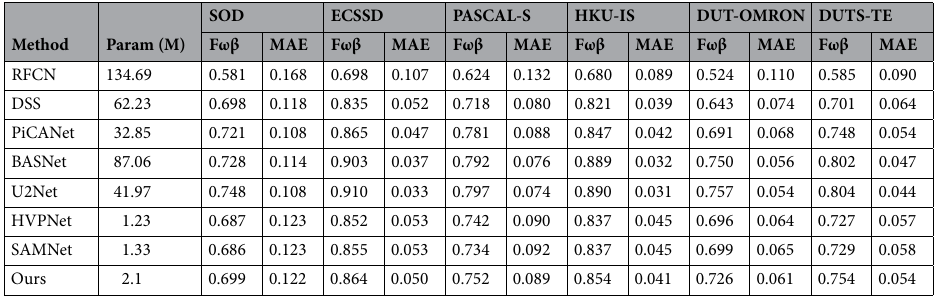
Table 1. Comparison with five traditional methods and two lightweight methods on F ω β ↑ and MAE ↓